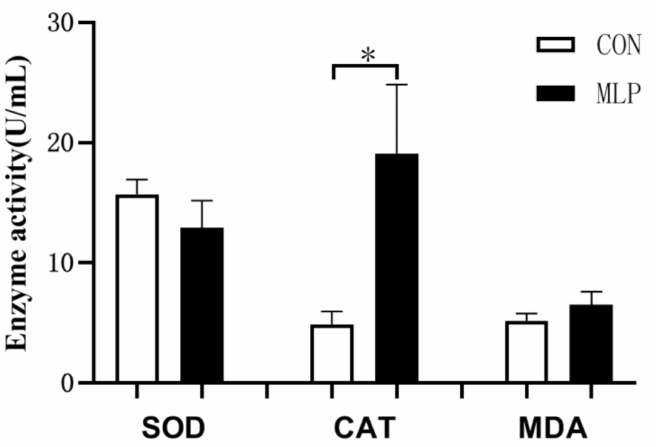
Figure 1. Effect of dietary supplementation with mulberry leaf powder (MLP) on serum antioxidant parameters in Tibetan pigs. Data are expressed as means ± SEM. * indicates a significant difference ( p < 0.05) between the MLP group and the control (CON) group. N =